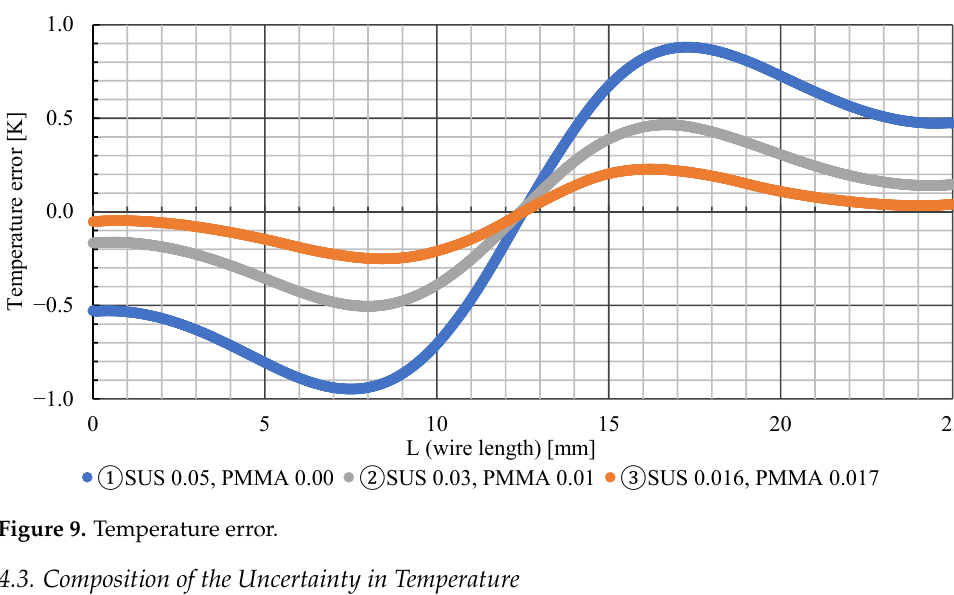
Figure 9. Temperature error.